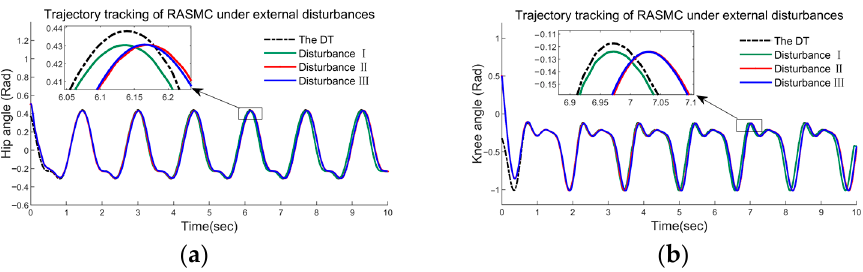
Figure 17. The tracking response of RASMC of the joints under Case III. ( a ) the response of θ 1 and ( b ) the response of θ 2 under the disturbances with different magnitudes.